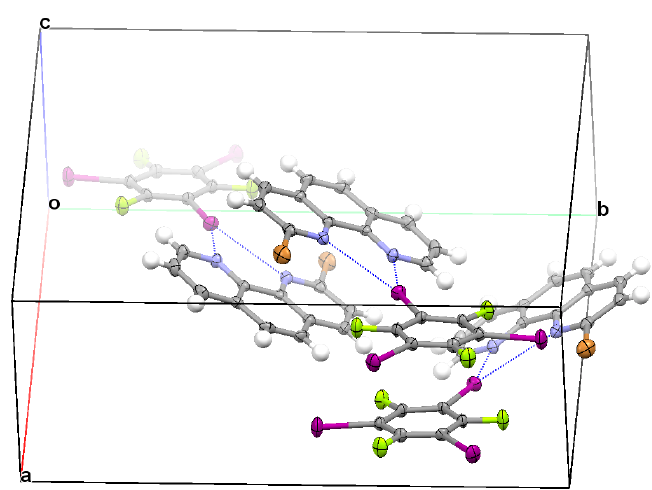
Figure 3. Part of the crystal structure of II showing the formation of asymmetrical bifurcated halogen bond, π · · · π stacking interaction between two TFTIB molecules, and π · · · π stacking interaction between two BrPHEN molecules.